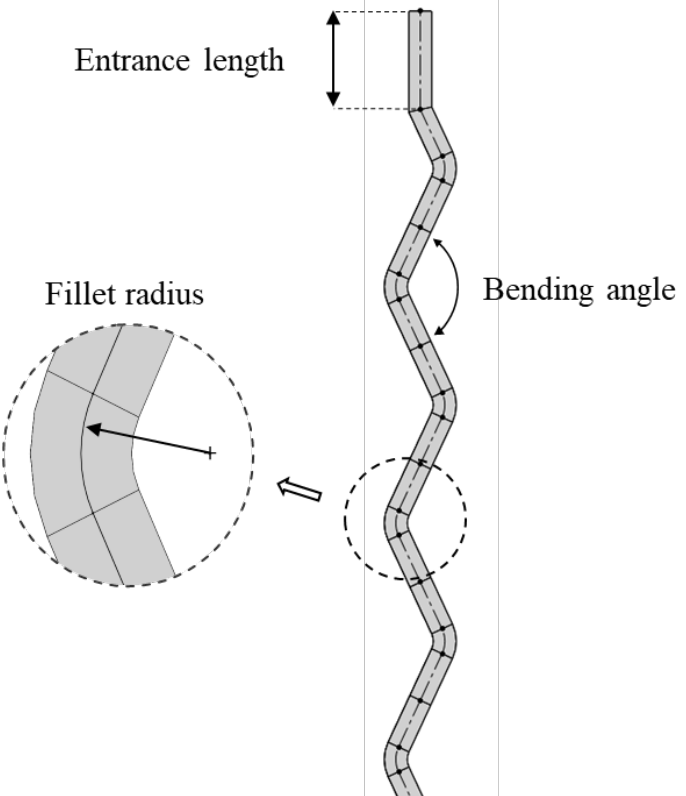
Figure 8. Schematic diagram of the three design parameters for a zigzag flow channel.